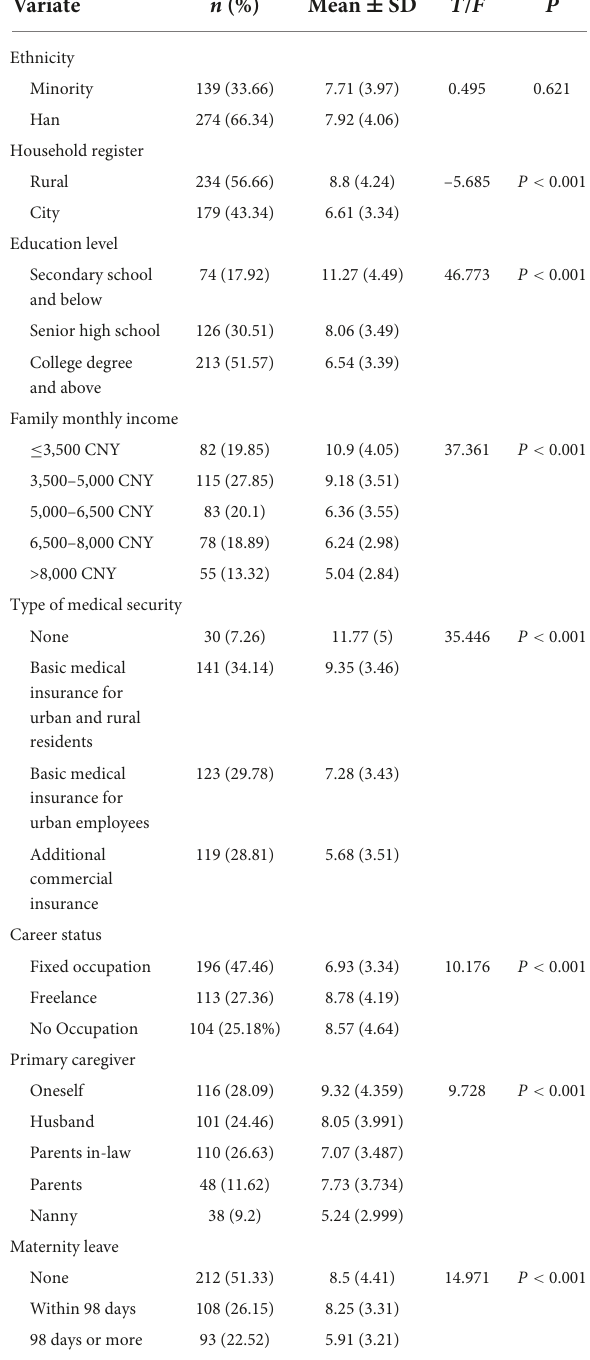
TABLE 1 Basic characteristics of samples and distribution of Edinburgh Postnatal Depression Scale scores.